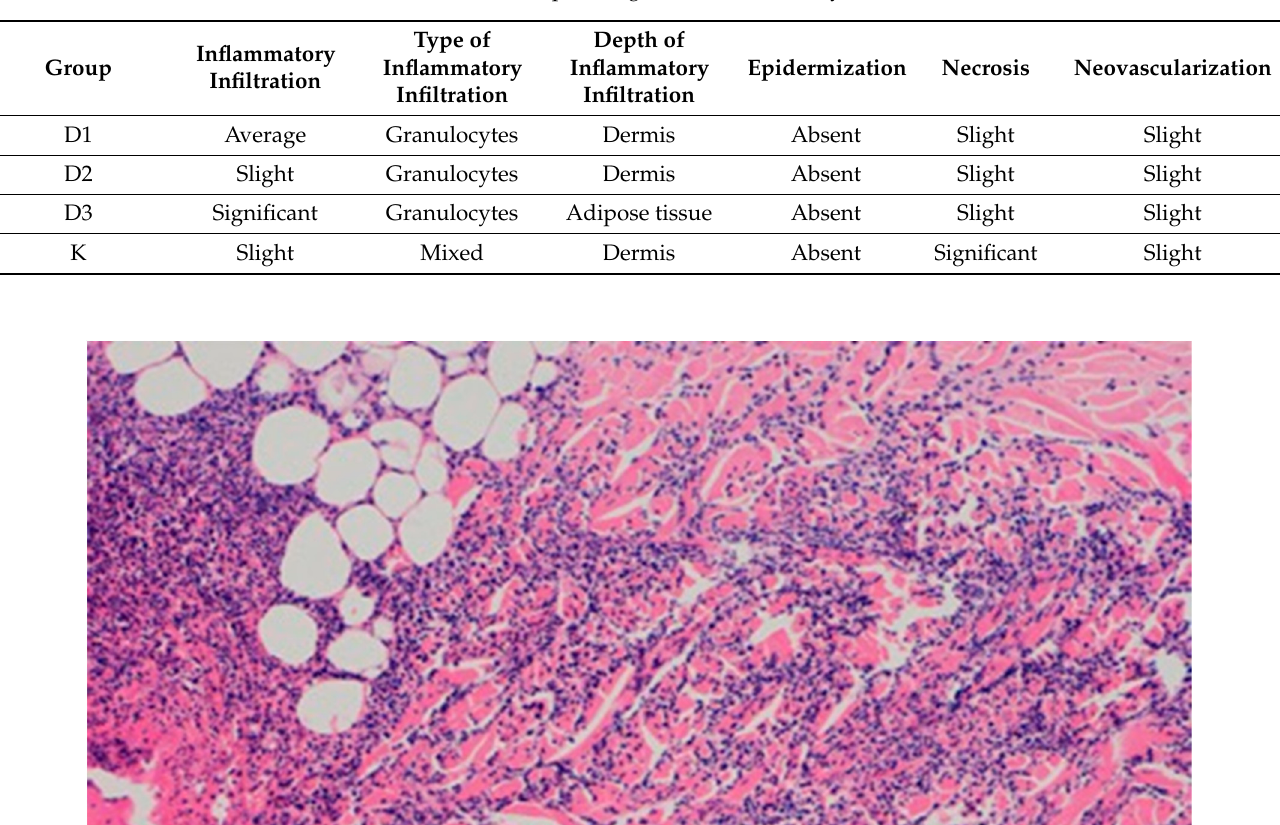
Table 8. Histopathological results from day 5.